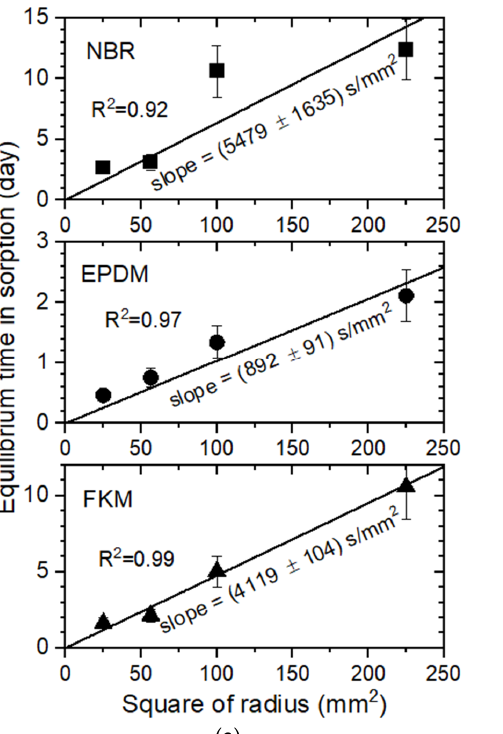
The reciprocal slope implies the diffusion coefficient.